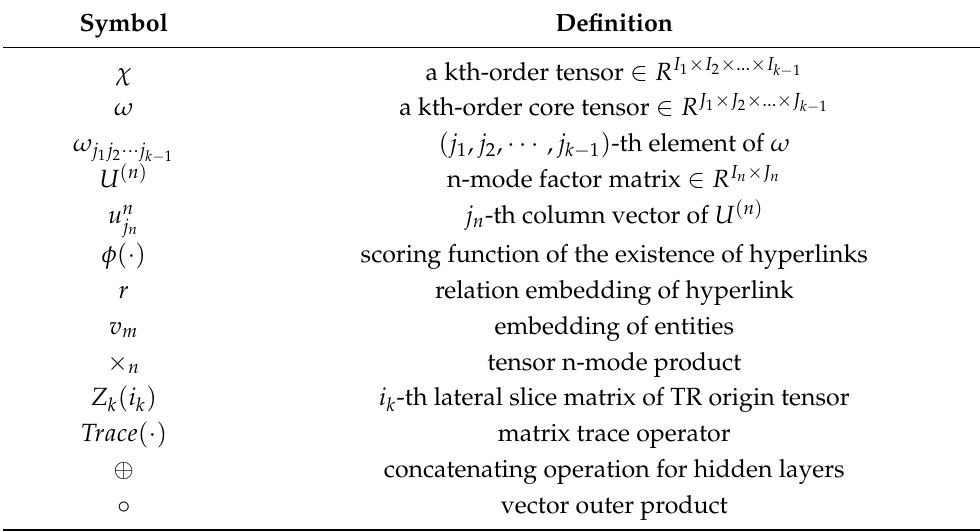
Table 1. Descriptions of notations used in the following